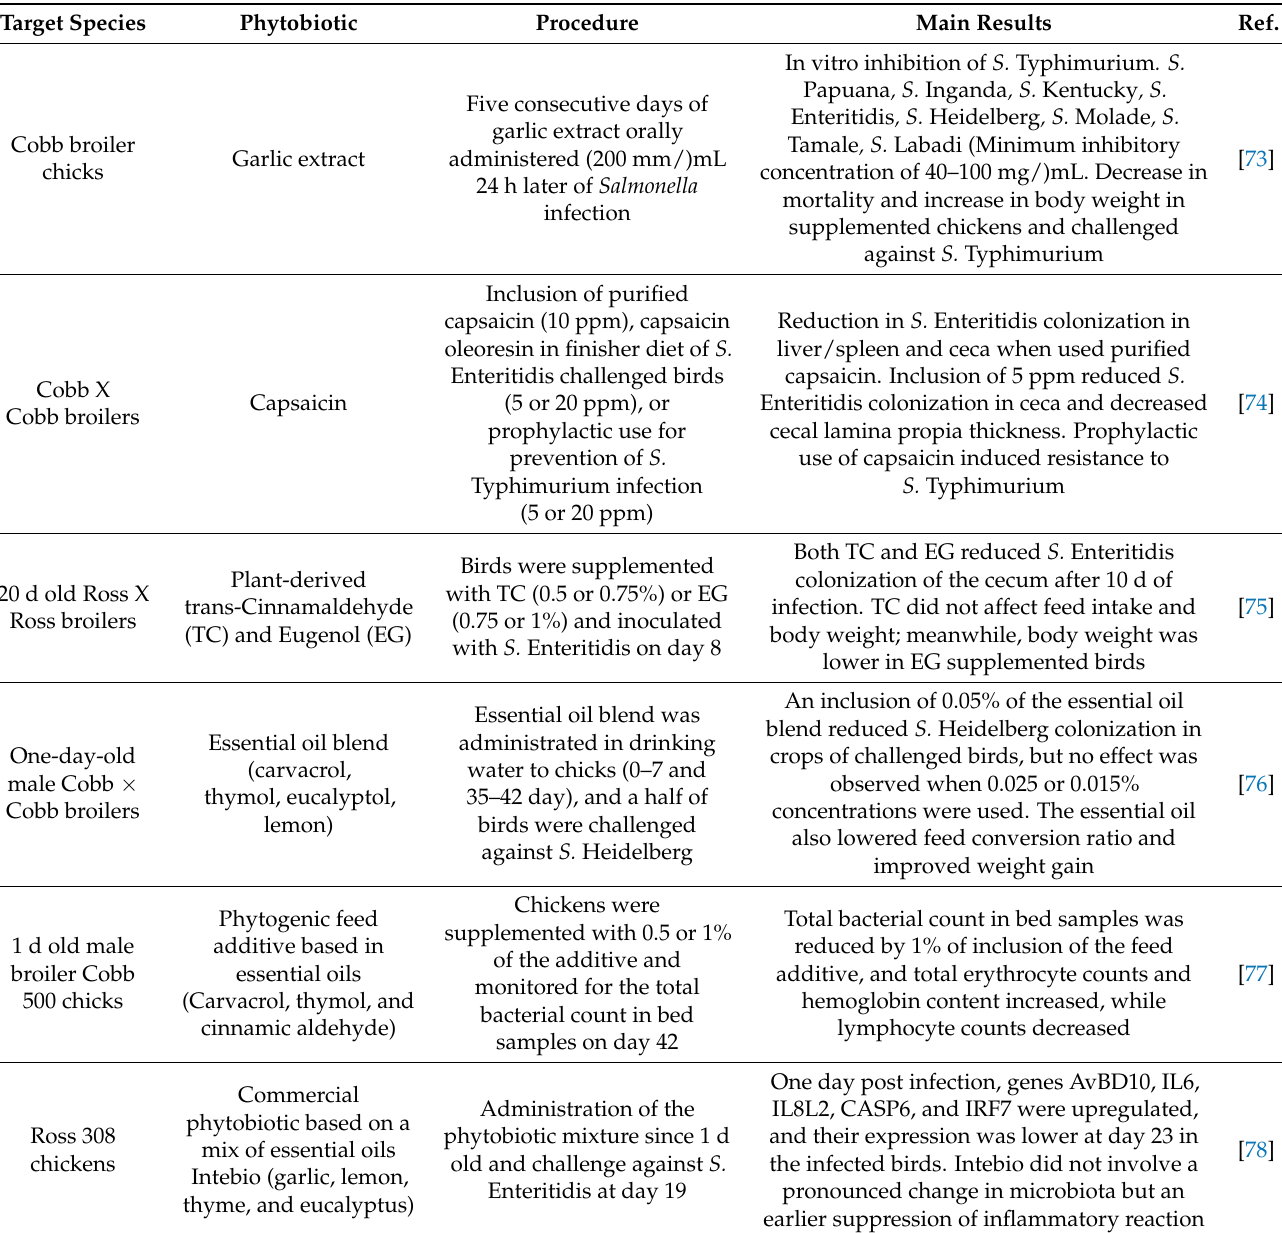
Table 5. Effects of dietary supplementation of phytobiotics as a strategy to control Salmonella in